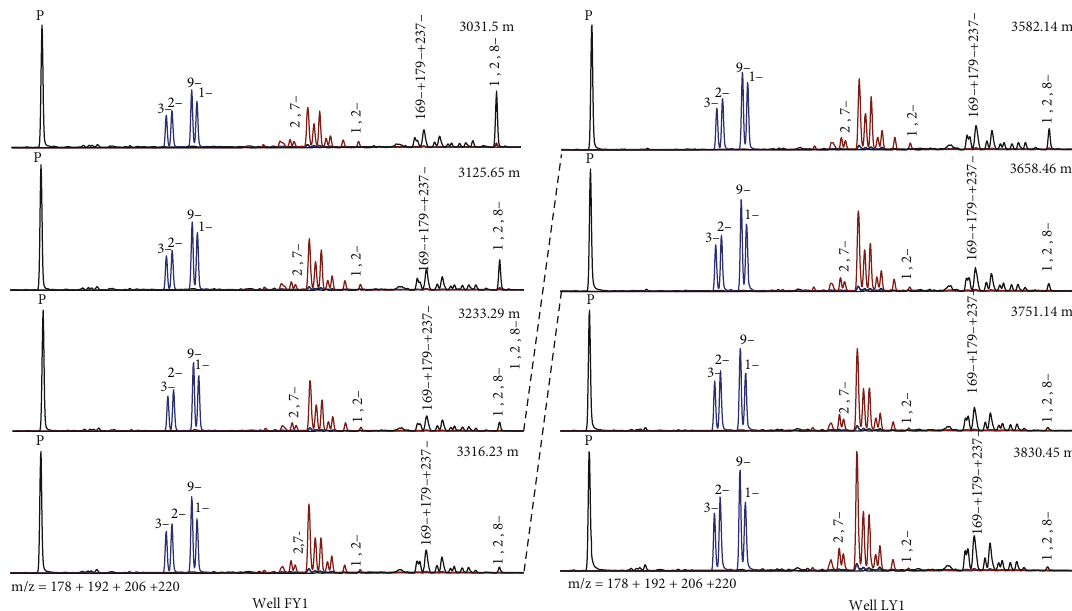
Figure 10: Mass chromatograms of m/z = 178 + 192 + 206 + 220 of the aromatic hydrocarbon fraction showing the typical distribution of C0-C3-alkylphenanthrenes with increasing burial depth in wells FY1 and LY1.